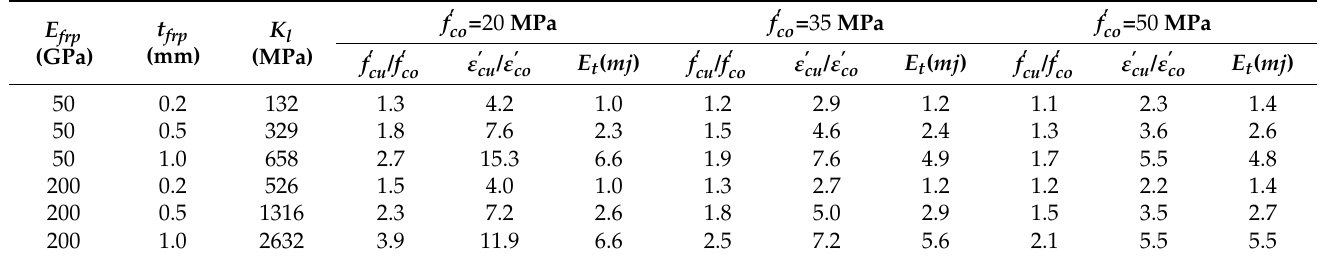
Table 4. Parametric study results of concrete confined with fibers in hoop